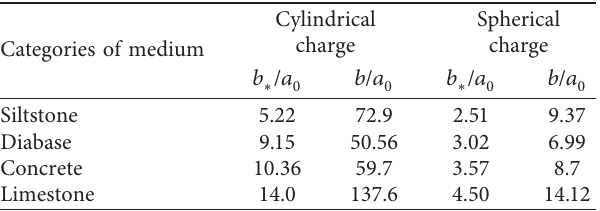
Table 7: Scope of damage zones of two charge forms under dif- ferent medium